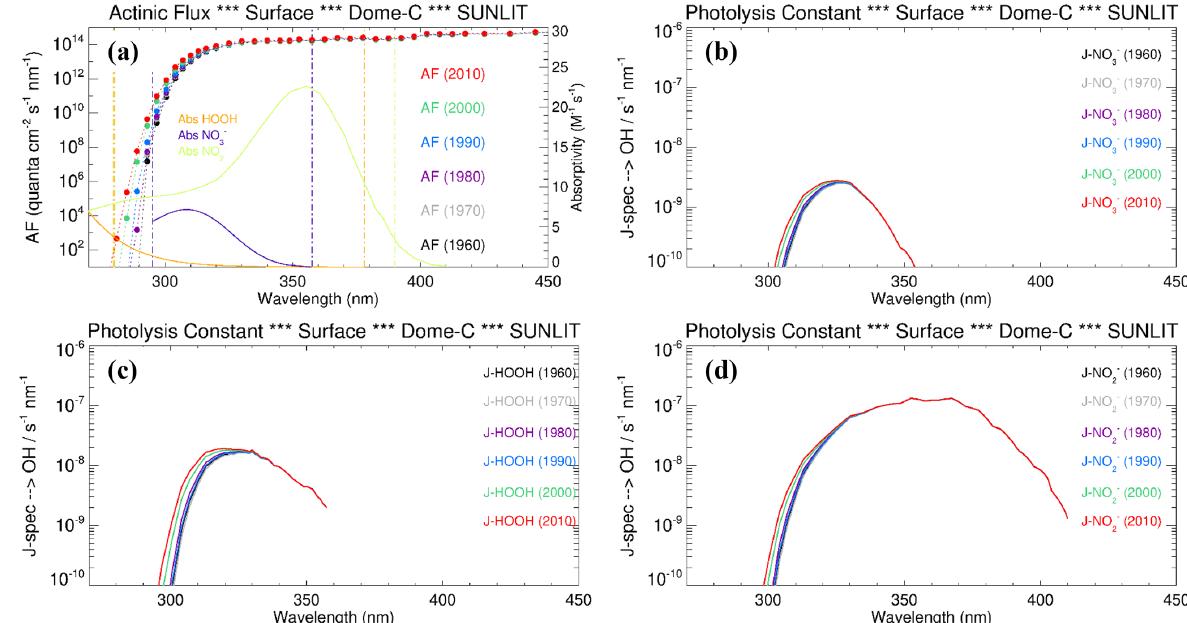
Figure 3. (a) The wavelength-dependent actinic flux (AF) at Dome C for different years (coloured dots), superimposed with the absorption (cid:113) spectrum of nitrate (violet line), hydrogen peroxide (orange line), and nitrite (green line). The photolysis rate for the main OH precursors as a function of wavelength in different years (pre and post the modern ozone hole) is shown for (b) nitrate, (c) hydrogen peroxide, and (d) nitrite. Table 2. Pearson correlations of 3 years moving average of Dome C Br, Na, and Br enr , Law Dome MSA (MSA LD ) and seasonal sea-ice ex- tents of the Indian Ocean (IO), western Pacific (WP), and Ross Sea (RS) sectors, and of the eastern Antarctic Ocean (EAO = IO + WP + RS), calculated as FYSI = ¯ Extent Sep–Dec − Extent Feb . The moving average is calculated in order to account for a dating error of ∼ 3 years. The correlations among the chemical species (Na, Br, Br enr , and NO − ) were made over the entire record (1800–2012), the correlations with 3 MSA LD were done between 1843–1995, the correlations with SAM (Marshall index) were done between 1957–2012, and the correlations with sea-ice extents were done between 1979–2012.